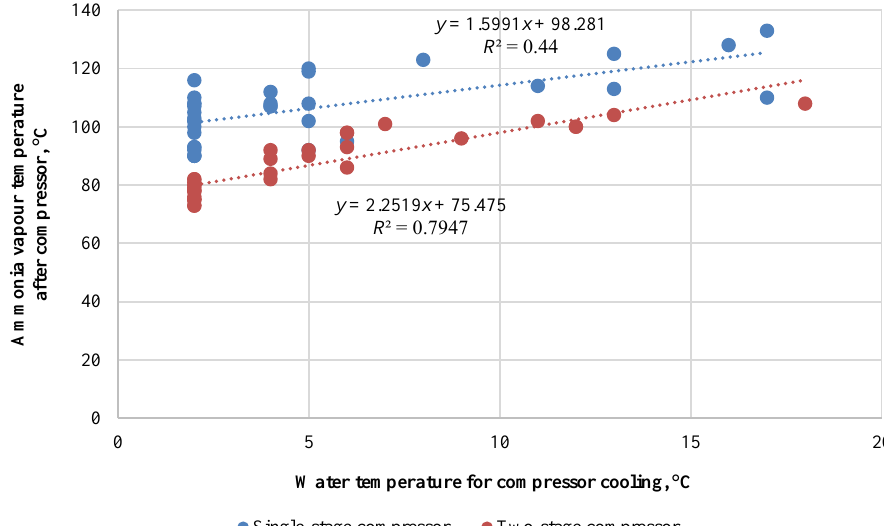
Fig. 11. Single-stage and two-stage compressor ammonia vapour temperature depending on cooling water